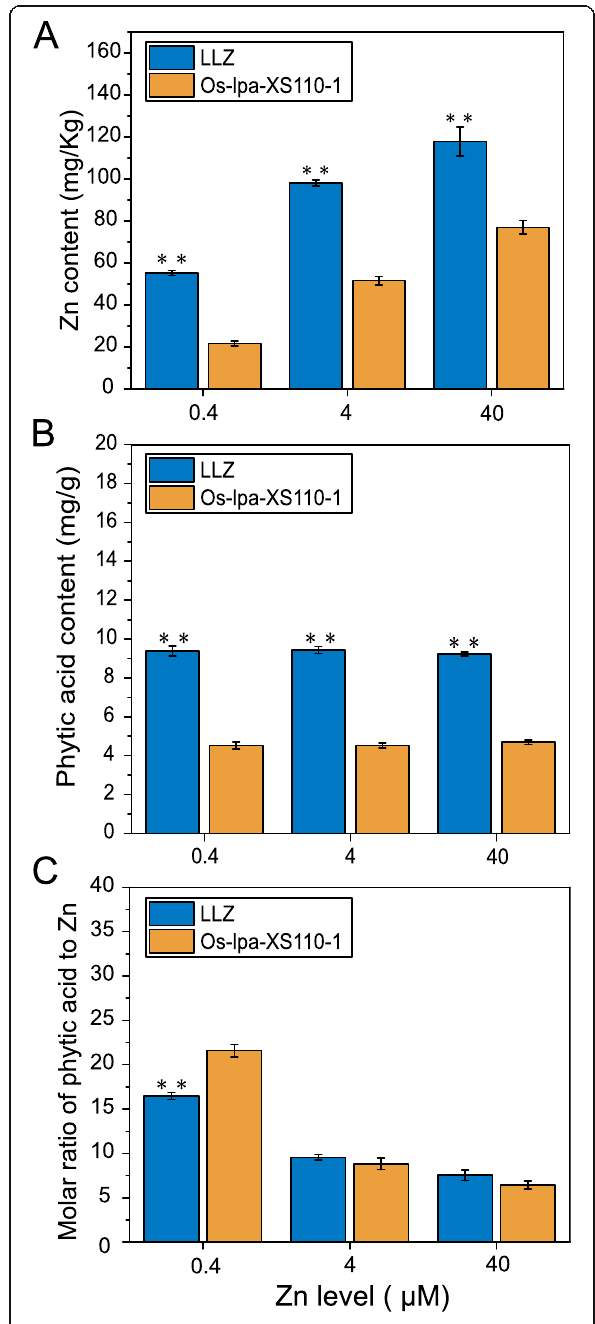
Fig. 1 Contents of Zn and phytic acid in LLZ and Os-lpa-XS110 – 1 under different Zn conditions. a Zn content in the brown rice; b Phytic acid content in the brown rice; c Molar ratio of phytic acid to Zn in the brown rice. The results are presented as mean ± SEM. Asterisks represent statistically significant differences between LLZ and Os-lpa-XS110 – 1 ( n = 4; * P < 0.05; ** P <